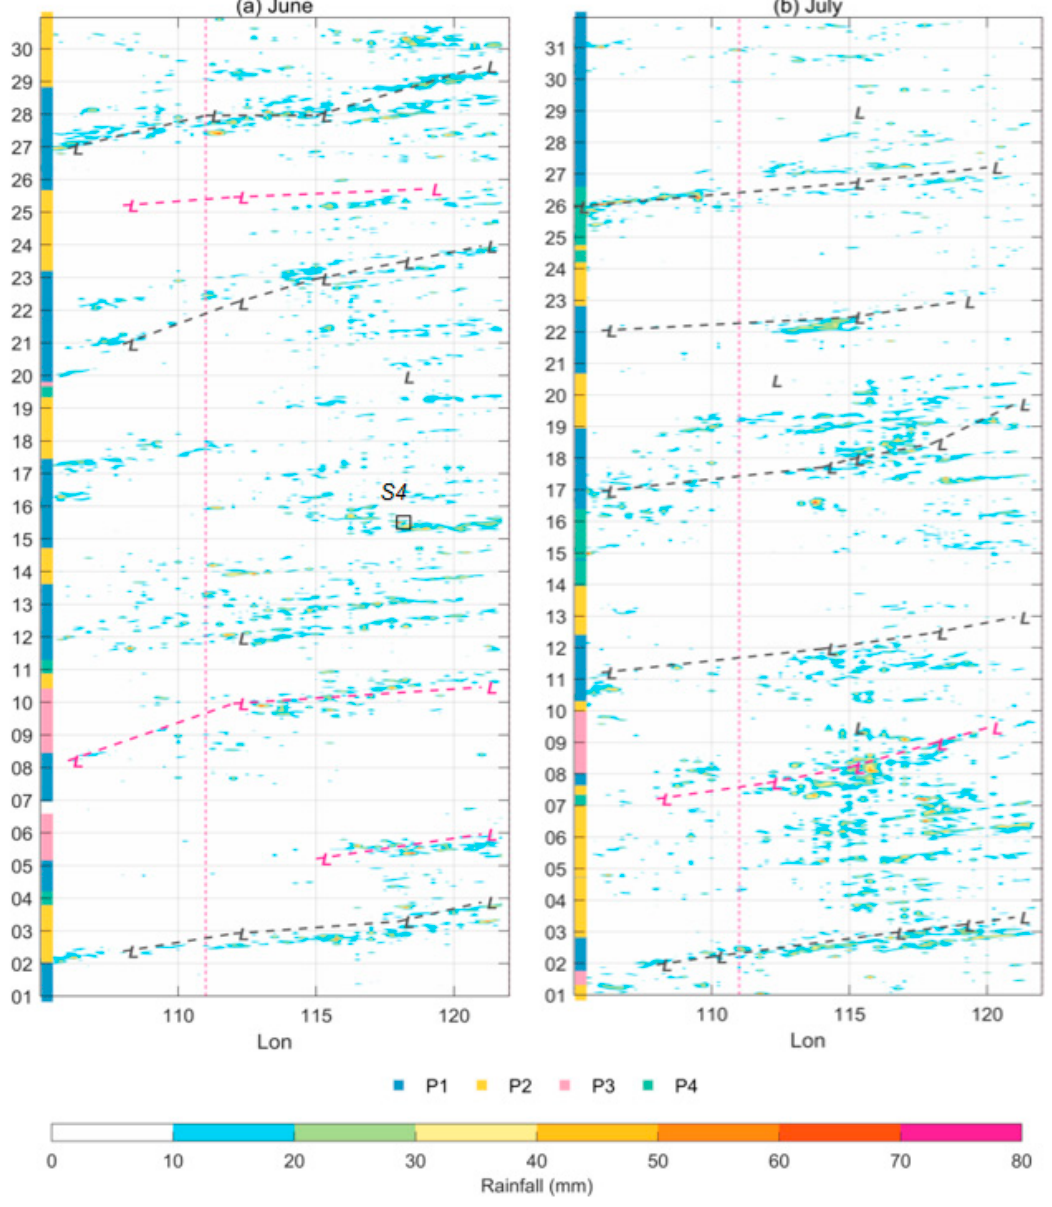
Figure 9. This is similar to Figure 6b,d but for Hovmöller (longitude–time) plots with the hourly rainfall averaged within 28–34 ◦ N. The colored blocks on the left frame of ( a , b ) denote the synoptic patterns (P1 is in blue, P2 is in yellow, P3 is in pink, and P4 is in green) at hourly intervals. The vertical red dotted lines denote the longitudinal range of our study area (111–122 ◦ E). The dashed lines are used to trace the temporal evolution of vortices, with their longitudinal location of the low-pressure center marked by the letter L . Vortices crossing the study area of the YHRB are marked in red and others are marked in gray. The time and longitude of national rain gauges that recorded the maximum hourly rain rates (S4) during June–July 2020 are marked by black squares.